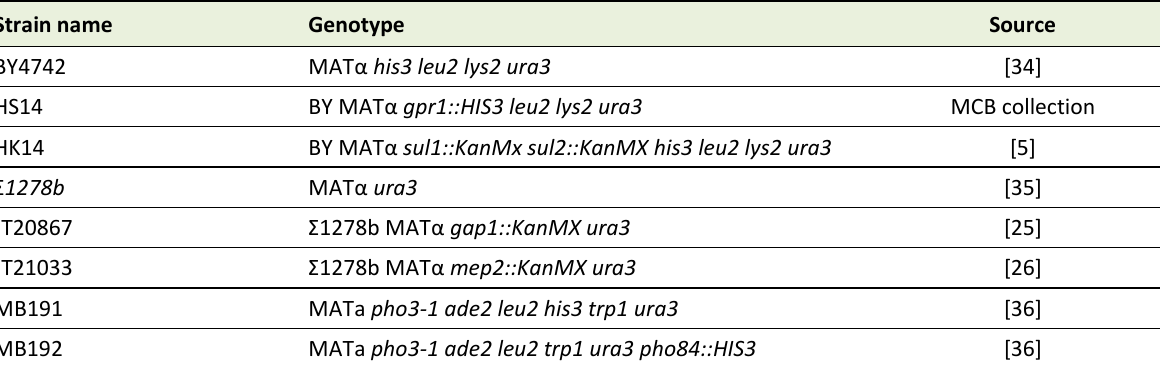
TABLE 1. S. cerevisiae strains used in this